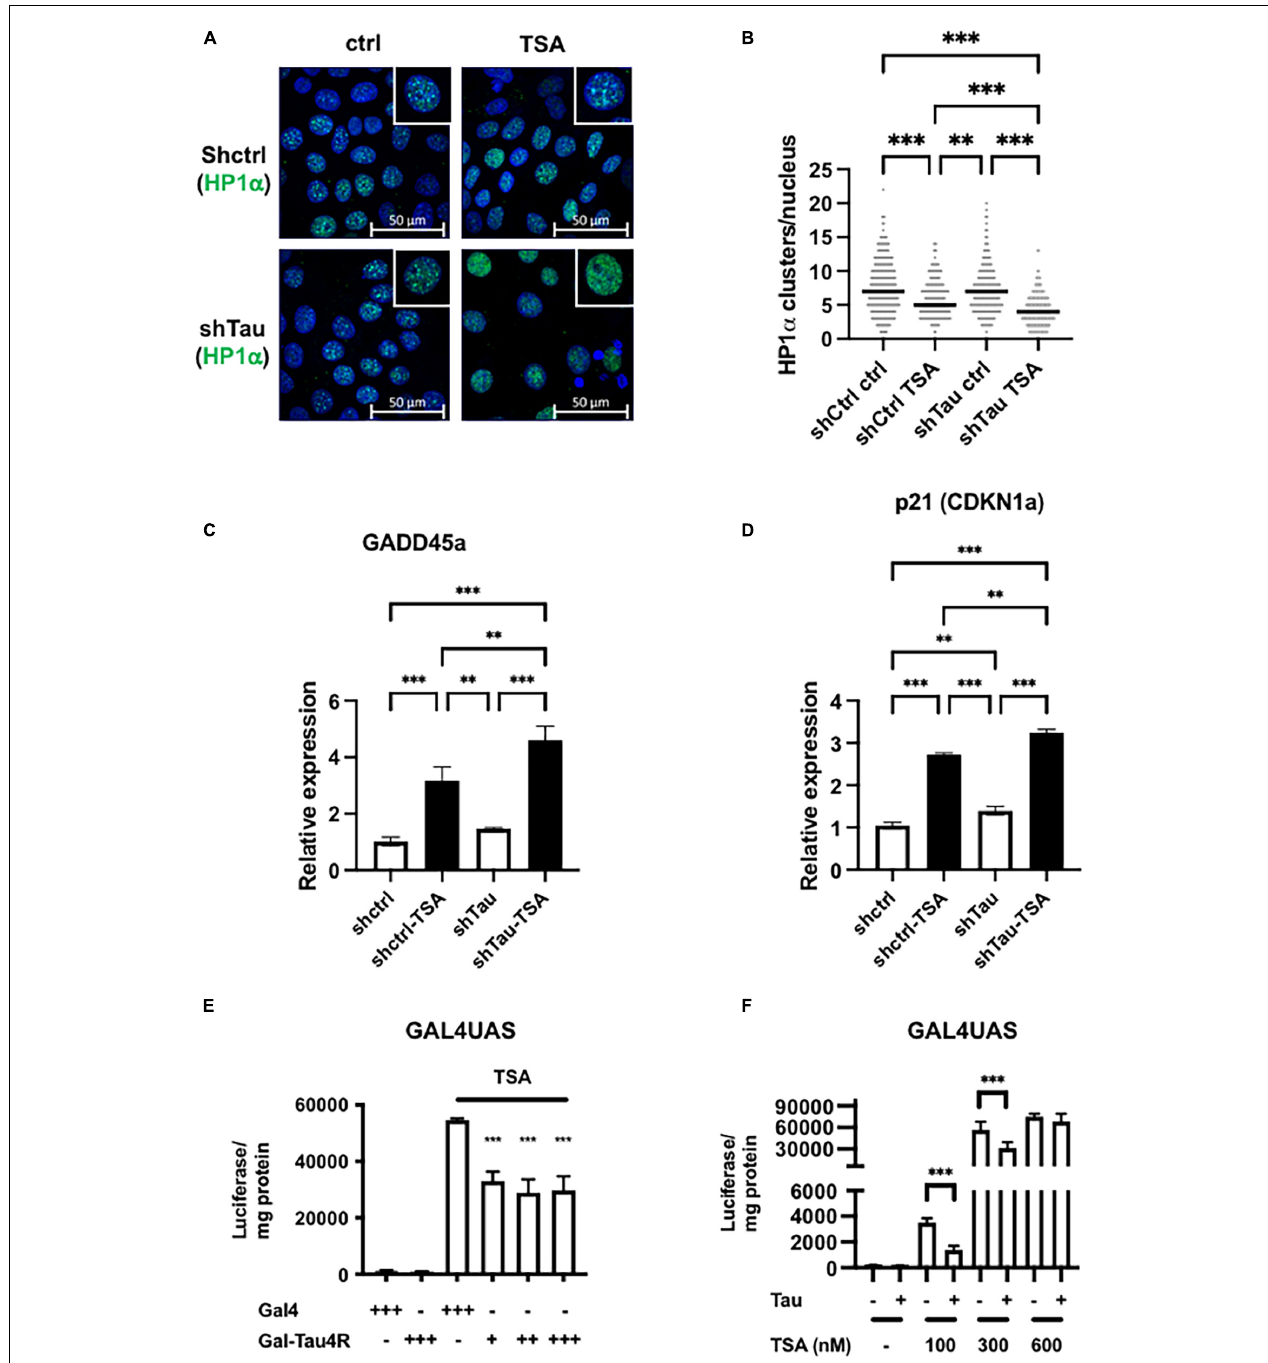
FIGURE 2 | Tau expression prevented TSA-dependent chromatin remodeling. (A) Representative confocal sections of MCF7shctrl and shTau cells untreated or treated with 100 nM TSA for 24 h. DNA was revealed by DAPI and HP1 α was immuno-localized. (B) Quantification of HP1 α clusters per nuclei visualized as described previously and realized on three independent experiments. (C) GADD45a and (D) p21 (CDKN1a) expression in MCF7shctrl and shTau cells untreated or treated with 100 nM TSA for 24 h were analyzed by real-time PCR and normalized to RPLO. Results are expressed, relative to the basal activity set to 1, as the mean ± SD of three independent assays. (E) Tau tethering prevents adjacent reporter gene activity induced by TSA. GAL4UAS responsive luciferase reporter Hela stable cell line was transfected with GAL4DBD (GAL4) or GAL4DBD-Tau4R and then, 24 h later, treated with TSA (600 nM) for 24 h. The luciferase activity was determined as described in in section “Materials and Methods.” (F) Ectopic Tau4R expression prevents adjacent reporter gene activity induced by TSA. The GAL4UAS responsive luciferase reporter Hela stable cell line was transfected with a plasmid encoding Tau4R for 24 h. Then, cells were treated with an increasing concentration of TSA, as indicated for 24 h. The luciferase activity was determined as described in section “Materials and Methods.” Data are mean ± SD, ∗∗ P < 0.01, ∗∗∗ P < 0.001 vs. control.